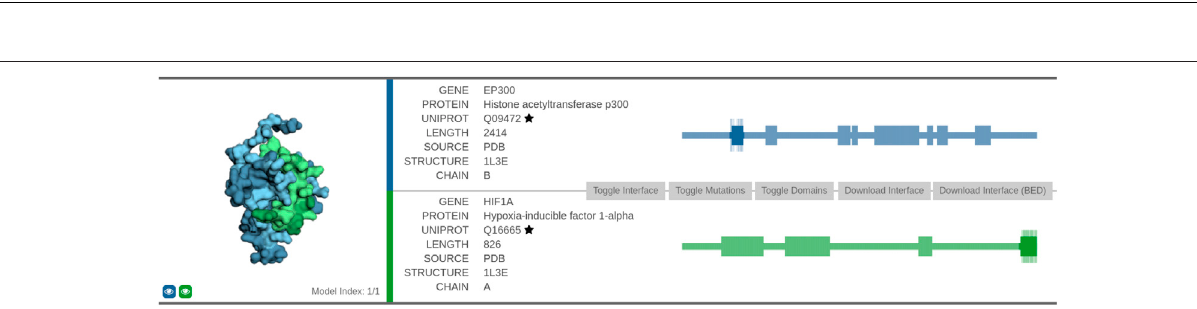
FIGURE 5 | Visualization of the predicted interaction interface as obtained by the Interactome INSIDER tool. The sequential view of the amino acid sequences with annotated domain information (rectangles) is shown in the rightmost part of the fi gure. Note the overlap between the fi rst domain of PTPN1 and the fi rst domain of CAPN1 — this domain overlap represents a potentially interesting protein interaction interface as predicted via ECLAIR.